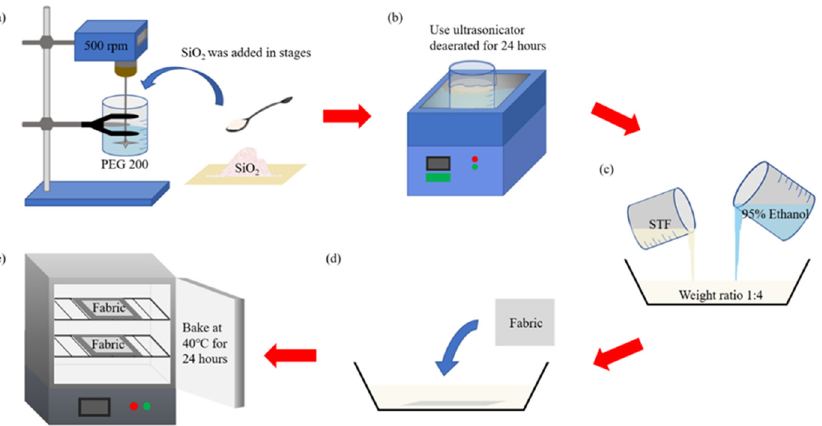
Figure 2. The preparation process of STF composites: ( a ) formulation of STF; ( b ) de-aerating STF; ( c ) dilution of STF; ( d ) STF impregnation of nonwoven fabrics; ( e ) thermal treatment of nonwoven fab- rics.